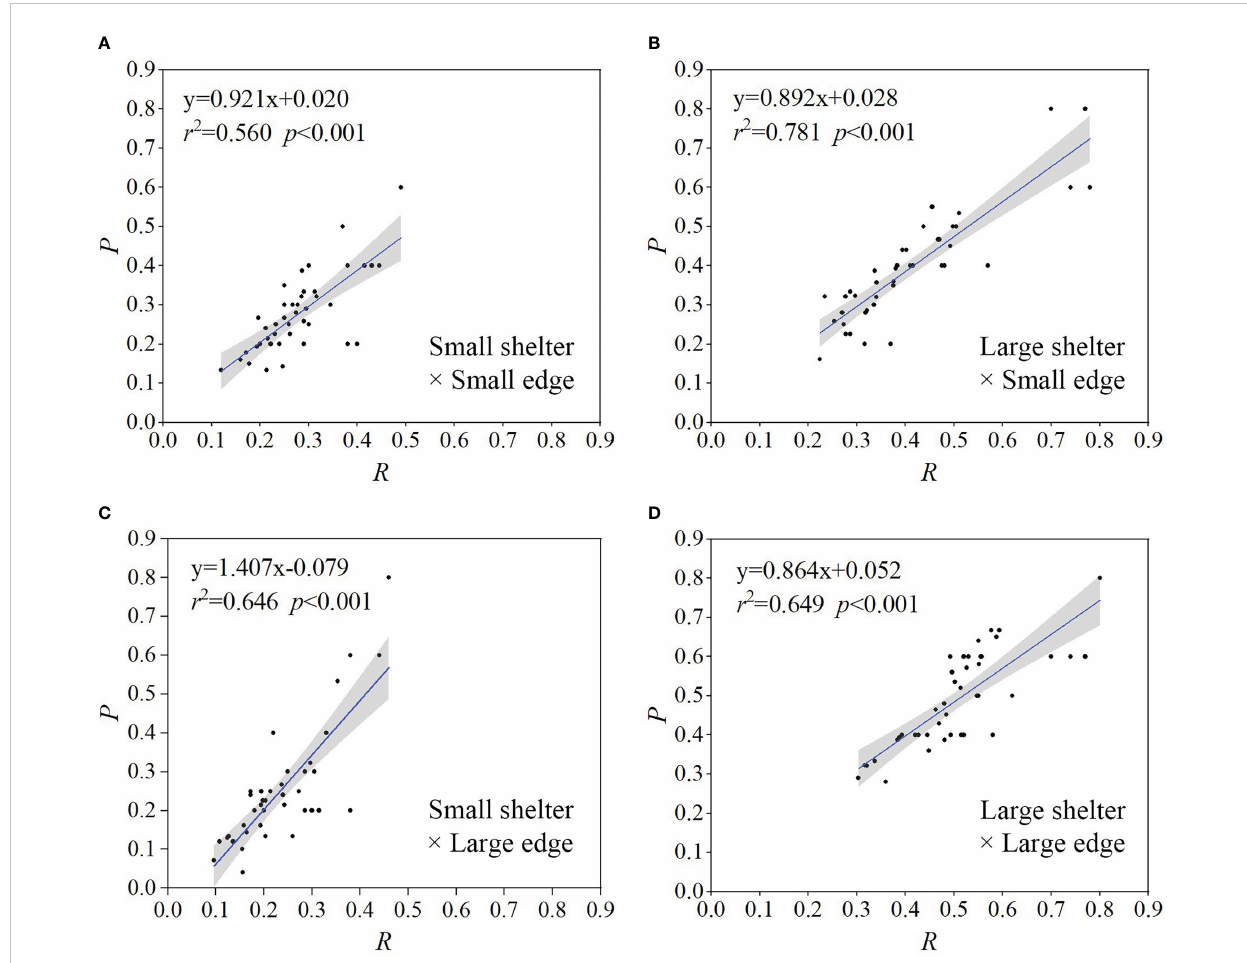
FIGURE 5 Relationship between the protection rate ( P ) and aggregation rate ( R ) for the four reef unit structures: (A) small shelter and small edge, (B) large shelter and small edge, (C) small shelter and large edge, (D) large shelter and large edge. Regression lines were generated using linear regression. Black dots represent raw data points. Shaded regions represent 95% con fi dence